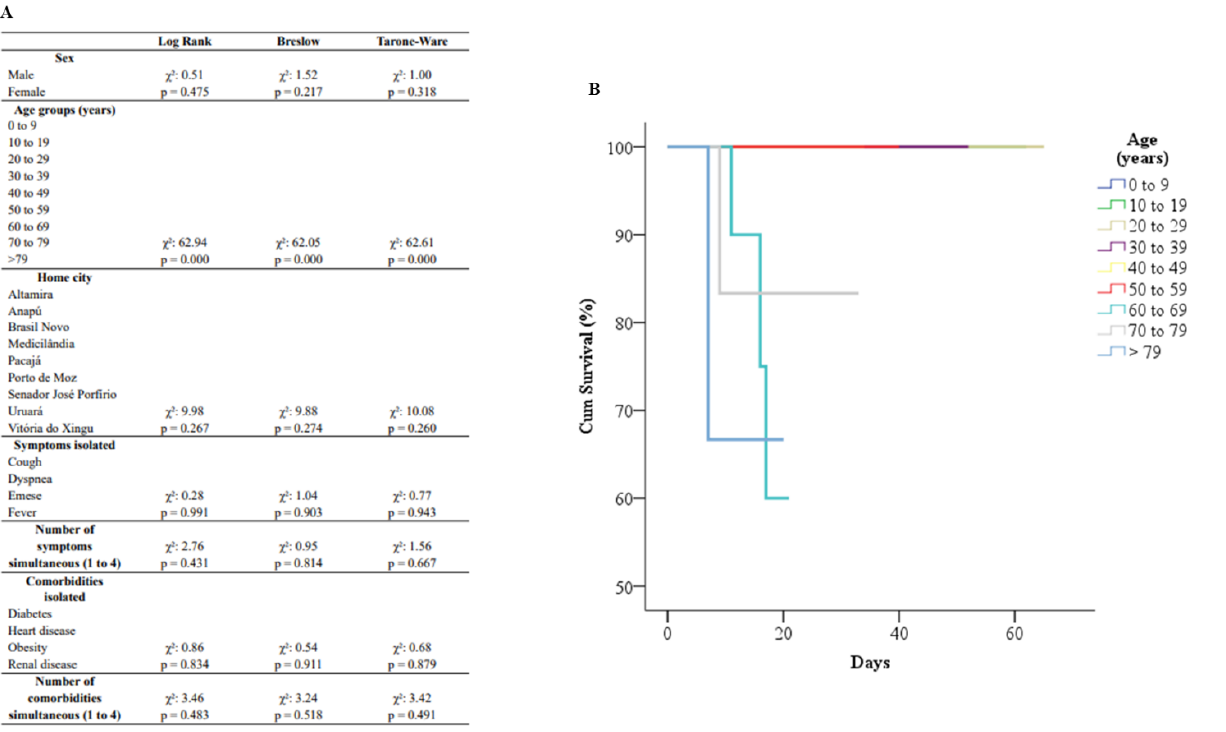
Figure 4. Kaplan–Meier survival analysis for COVID-19 by sex, age groups, home city, symptoms Figure 4. Kaplan – Meier survival analysis for COVID-19 by sex, age groups, home city, symptoms and comorbidities ( A ); representation graphic for age groups ( B and comorbidities ( A ); representation graphic for age groups ( B ).